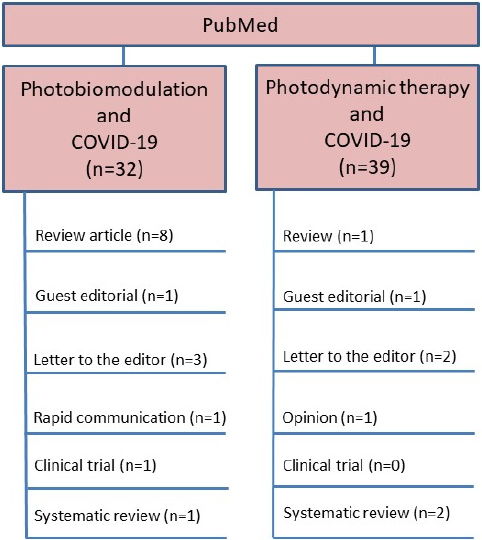
Figure 1. PubMed results on COVID-19 and photobiomodulation or photodynamic therapy (as of June 2021).